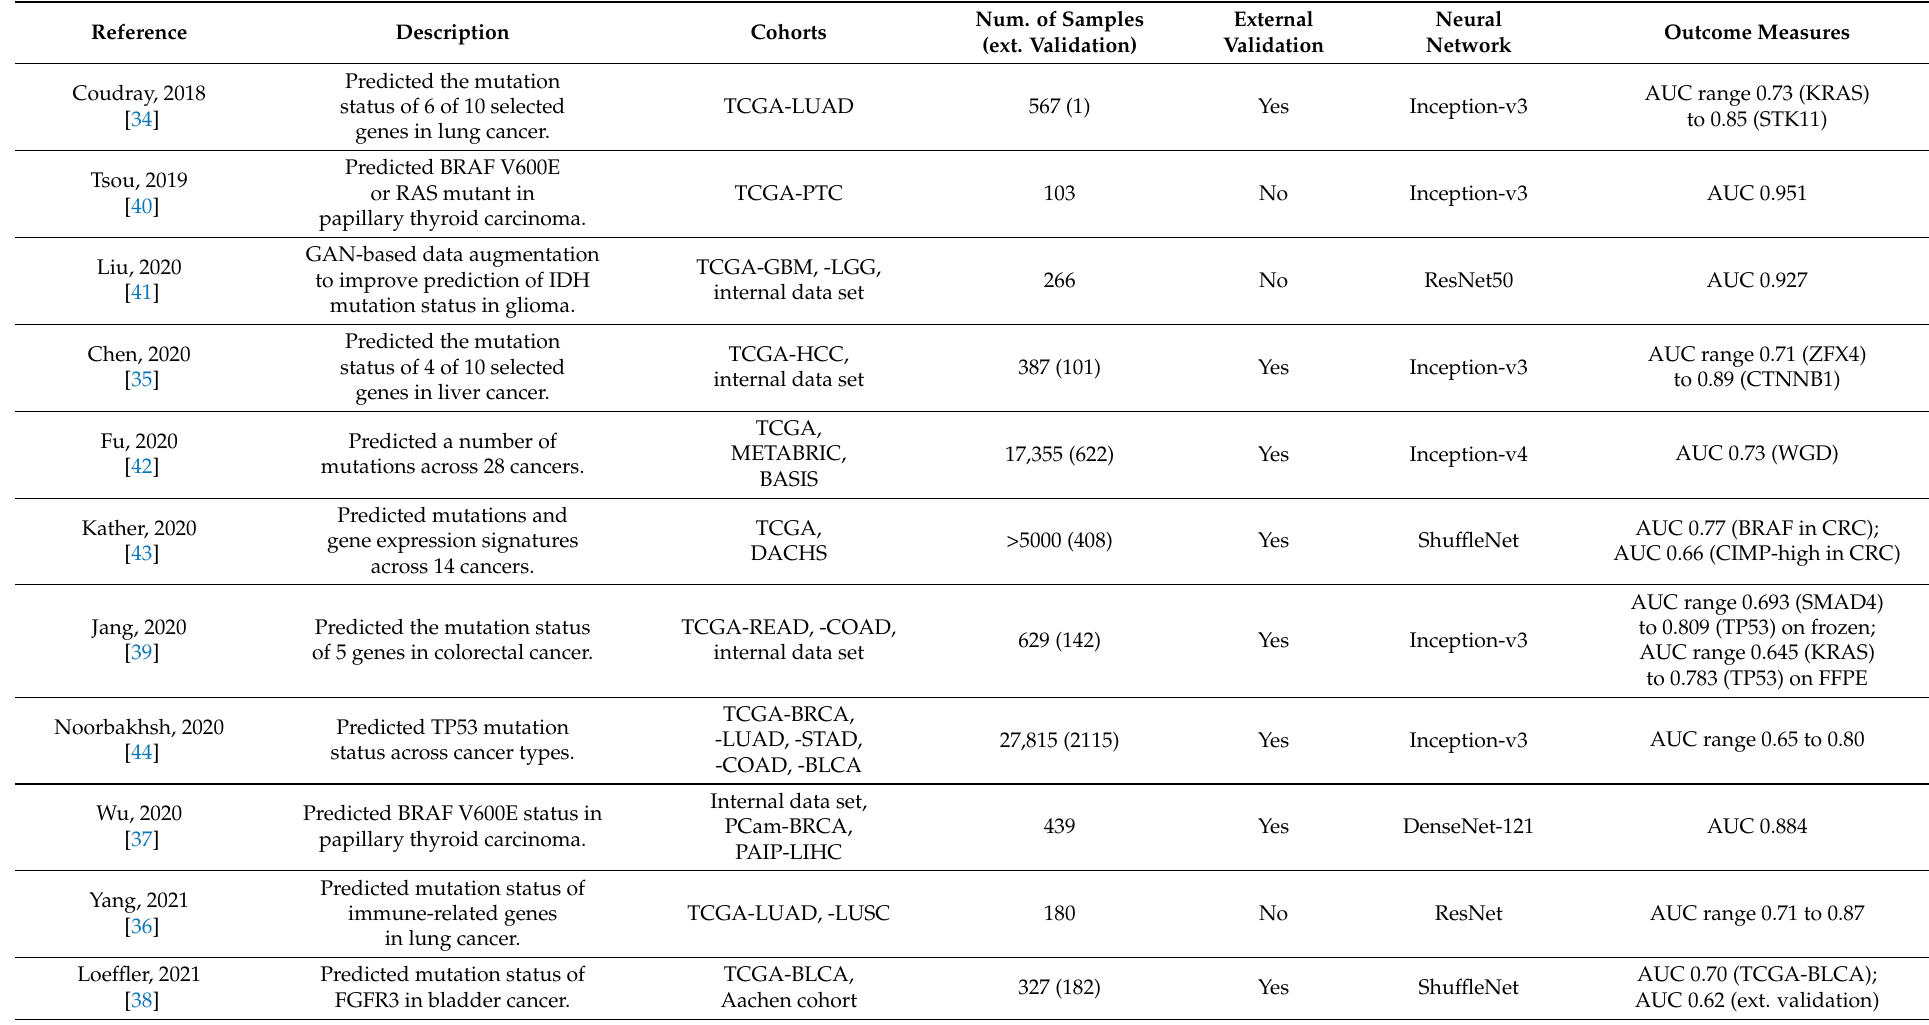
Table 1. Comparison of studies aimed at predicting mutations from digitised histolpathology slides using deep